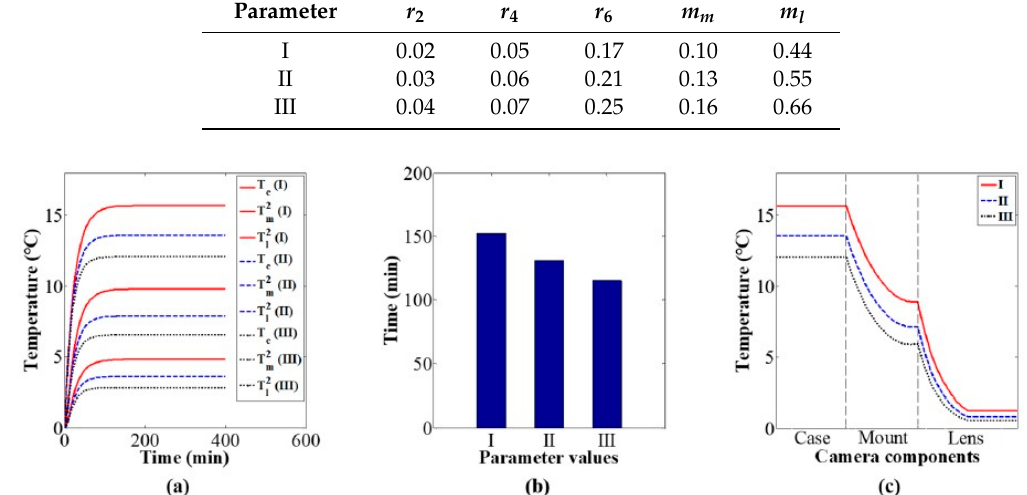
Figure 9. Effect of heat convection parameters on camera component temperature variation and distribution: ( a ) components temperature variation, ( b ) thermal equilibrium time, and ( c ) distribution of equilibrium temperature.